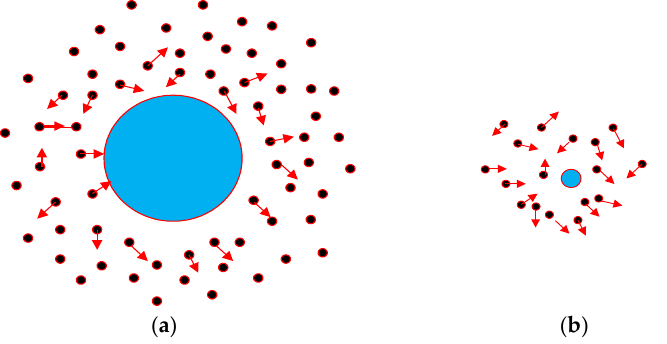
Figure 1. Growth of water droplets in supersaturated steam. ( a ) Knudsen number ( Kn ) < 0.01; and ( b ) Kn > 4.5.